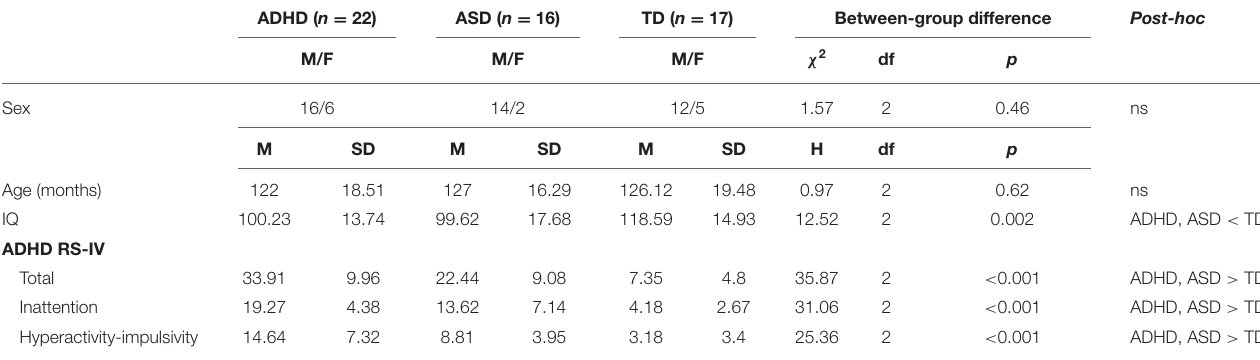
TABLE 1 | Demographic